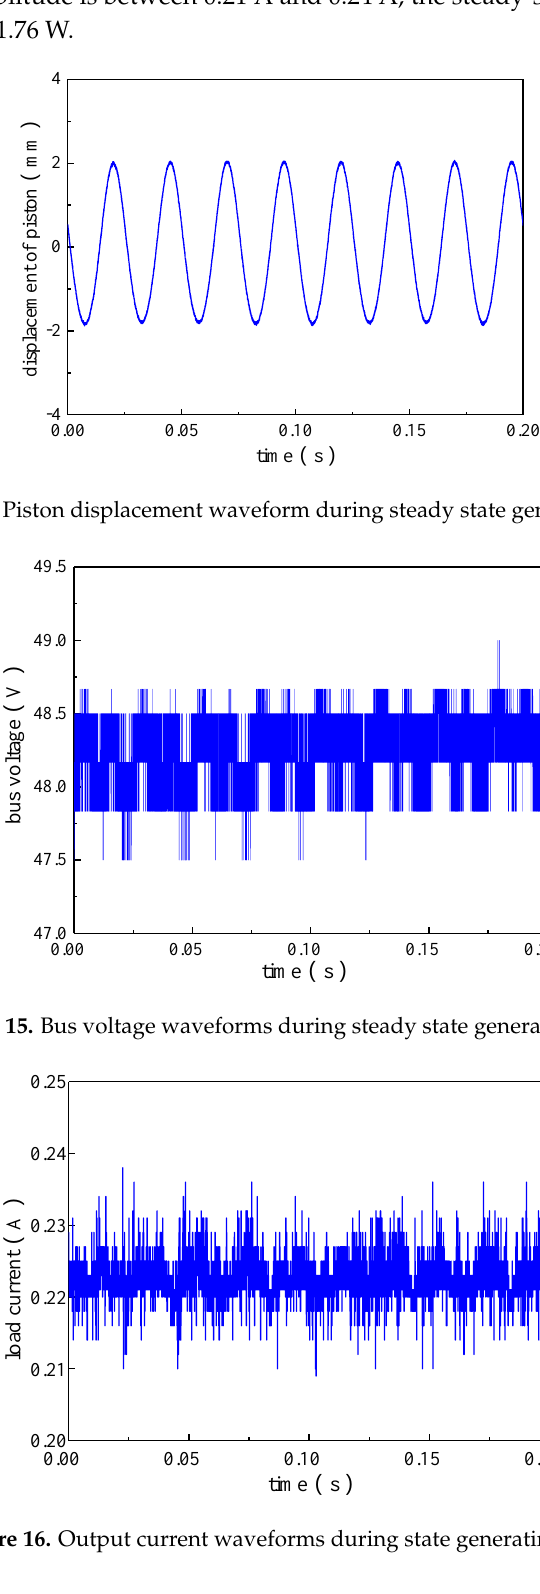
( b ) Figure 17. Generator voltage waveforms and current waveforms during steady state generating test: ( a ) generator voltage waveforms; and ( b ) generator current waveforms. It can be seen from the experimental results that the piston stroke is stable during the stable generation of the power generating system; the output bus voltage is basically the same as the reference value; and the ripple is very small, which proves that the power generating system has good steady-state power generation performance. As can be seen in Figure 17, the amplitude of the back electromotive force of the A and B phases of the motor is significantly smaller than that of the C phase, which is due to the influence of the end effect. 5.2.2. Transient Experiment To verify the effectiveness of the power generating control strategy, Figure 18 shows the piston displacement waveforms with variable load during generating test. The figure shows that the piston stroke is approximately 4.5 mm when the system is stable. When the power generation continues stably about 25 s, the load resistance is increased, which decreases the stroke of the piston. After 5 s of adjustment, the power generating system reaches a new steady state, where the piston stroke is about 3.2 mm. When the system is stable in generation state for 10 s, the load resistance is restored to the initial value. The stroke of the piston is gradually steady, basically the same as the initial state, and the adjustment time is about 3 s. In this process, the average pressure difference on both sides of the piston during the movement causes the balance point of the piston drifting to one side.